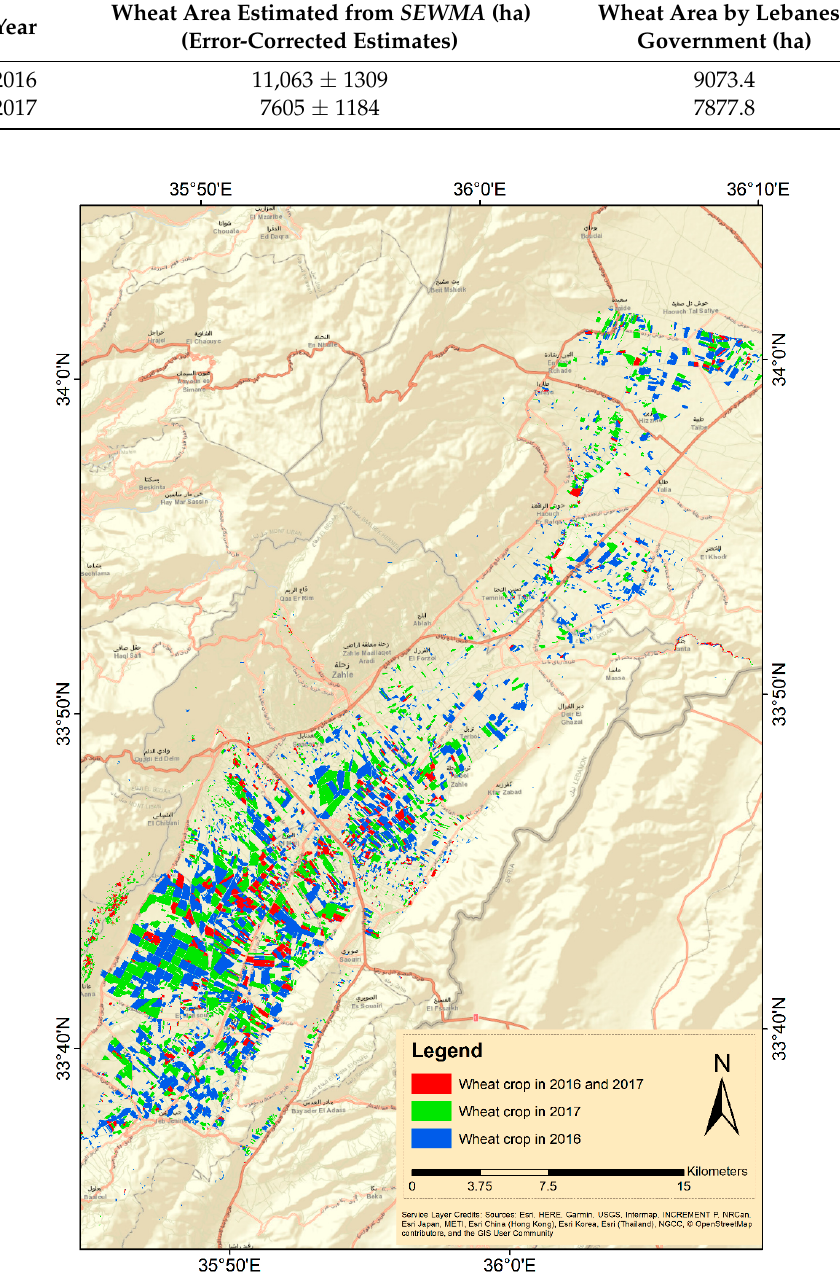
Figure 9. Spatial distribution of wheat in the Bekaa plain for years 2016 and 2017.